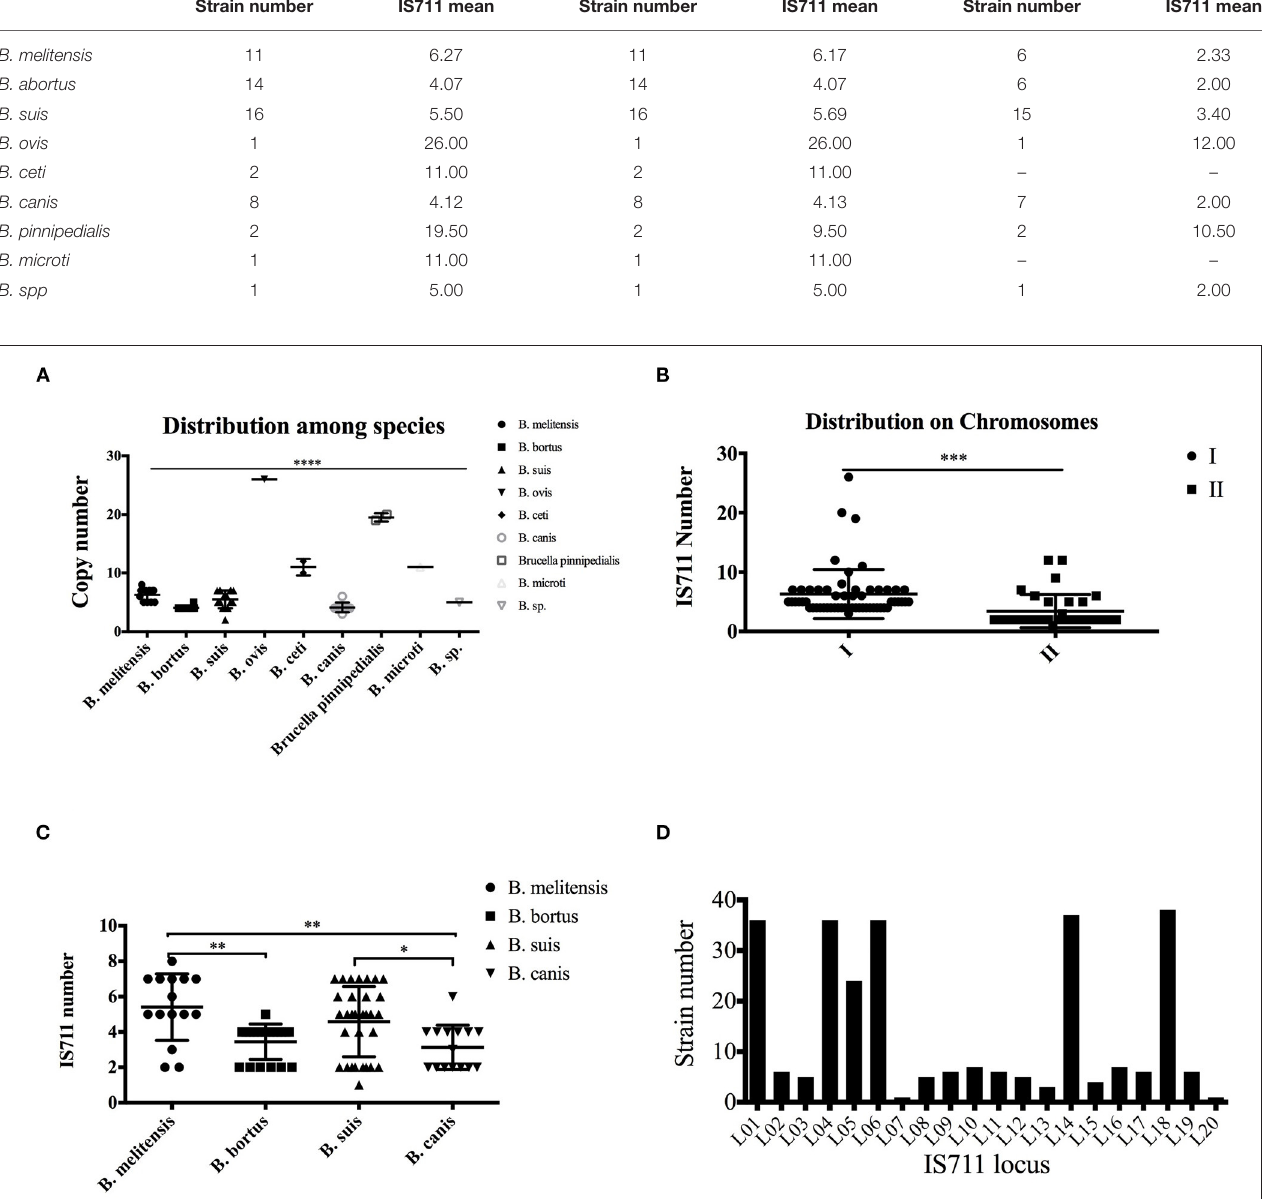
FIGURE 3 | Differential distribution of IS711 among different Brucella species. Copy number of IS711 was calculated for each of the nine Brucella species. IS711 copy number varies significantly among the species (A) . Copy number of IS711 on chromosome I is significantly higher than that on chromosome II (B) . IS711 copy numbers were compared between the four species that infect humans. B. melitensis has a higher copy number of IS711 than B. abortus and B. canis (C) . A total of 20 IS711 locus were identified, and they are differentially distributed among the strains (D) . **** P < 0.0001, *** P < 0.001, ** P < 0.01, * P < 0.05.